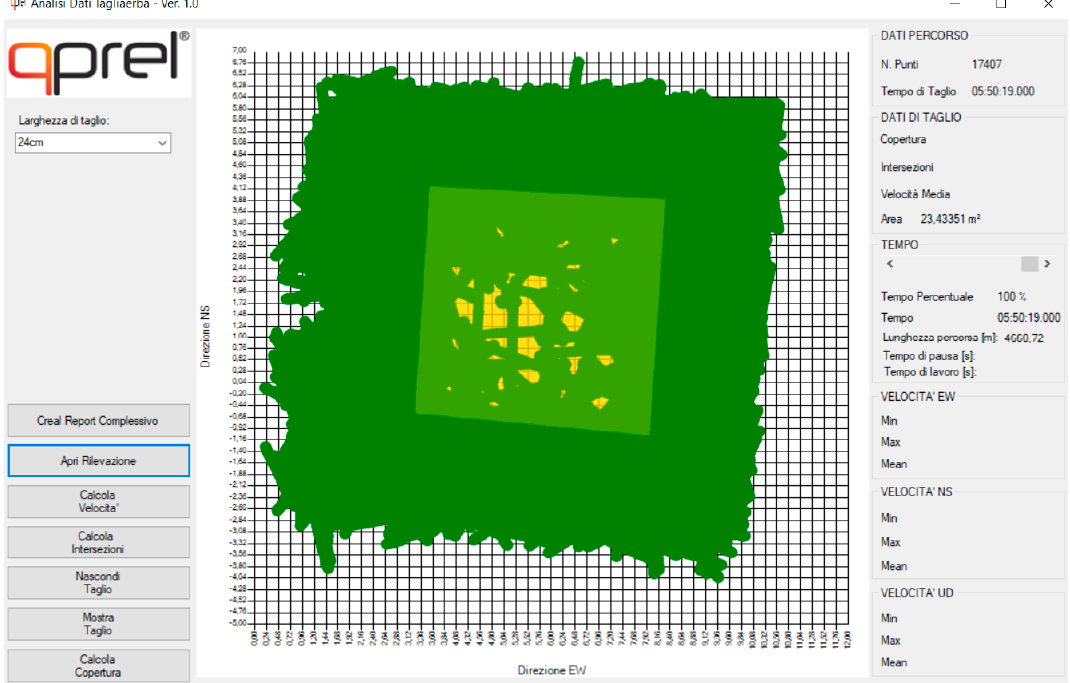
Figure 3. Custom-built software “Robot mower tracking data calculator” showing the percentages of Table 1. (green lines) at 100% of the working time on Site B (on 15 February 2019). The yellow area is the area with obstacles (extension: 23.04 m 2 ).